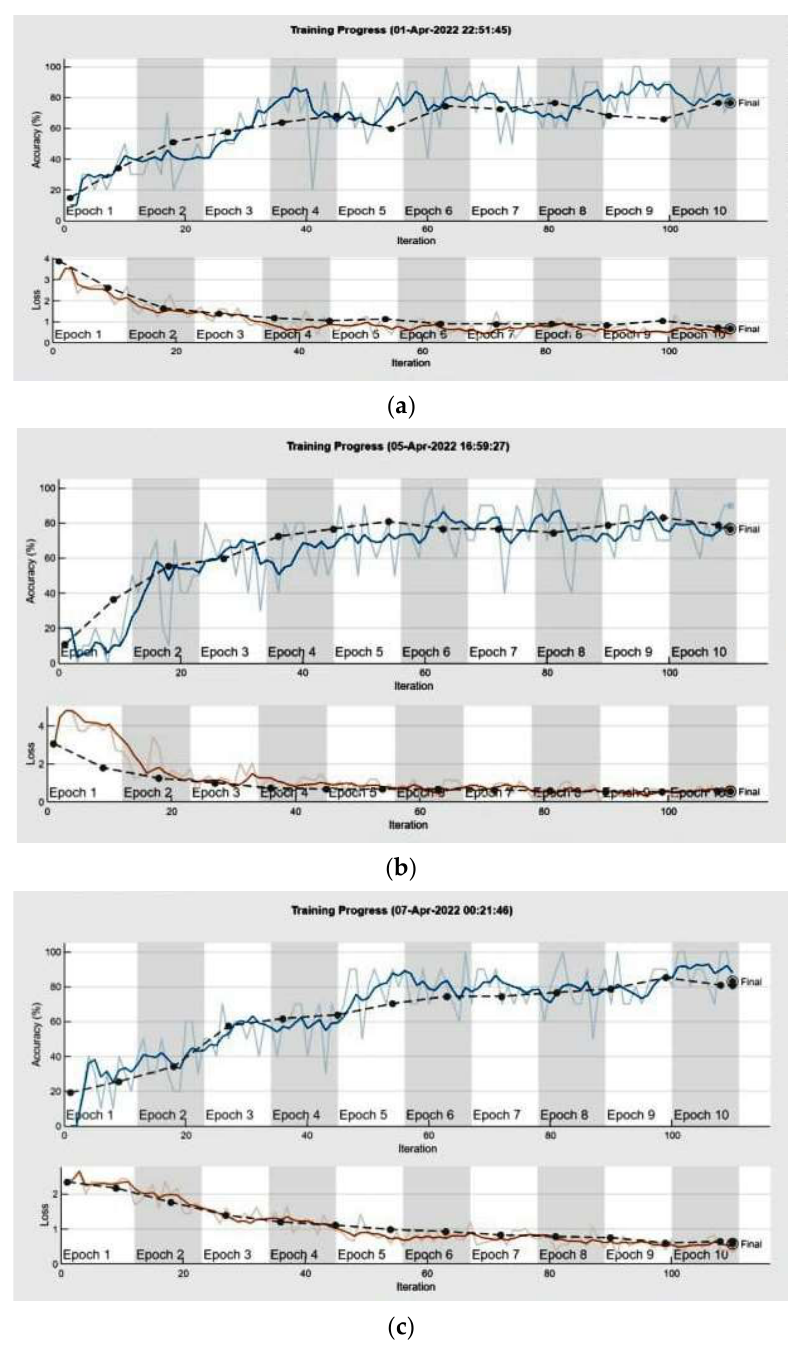
Figure 9. Training accuracy: ( a ) SqueezeNet, accuracy of 76.60%. ( b ) AlexNet, accuracy of 76.60%. ( c ) ResNet-50, the accuracy of 82.98%.